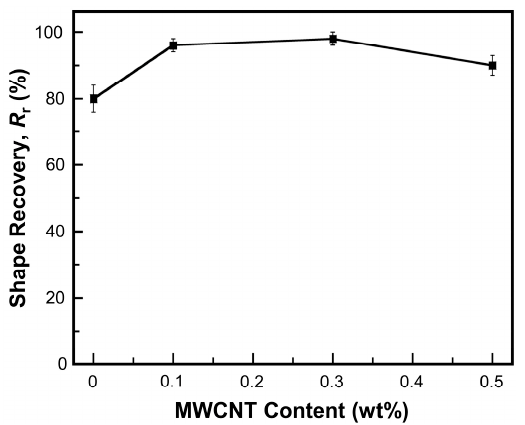
Figure 11. Shape recovery under NIR-actuation of MWCNT reinforced V-fa/ECO composites at various MWCNT contents.